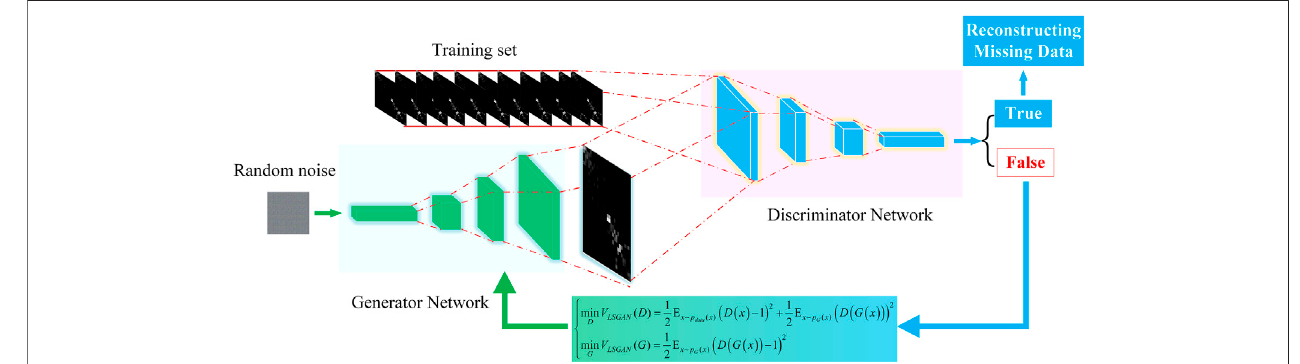
FIGURE 3 | Flow chart of the reconstruction method for missing power data based on LSGAN.